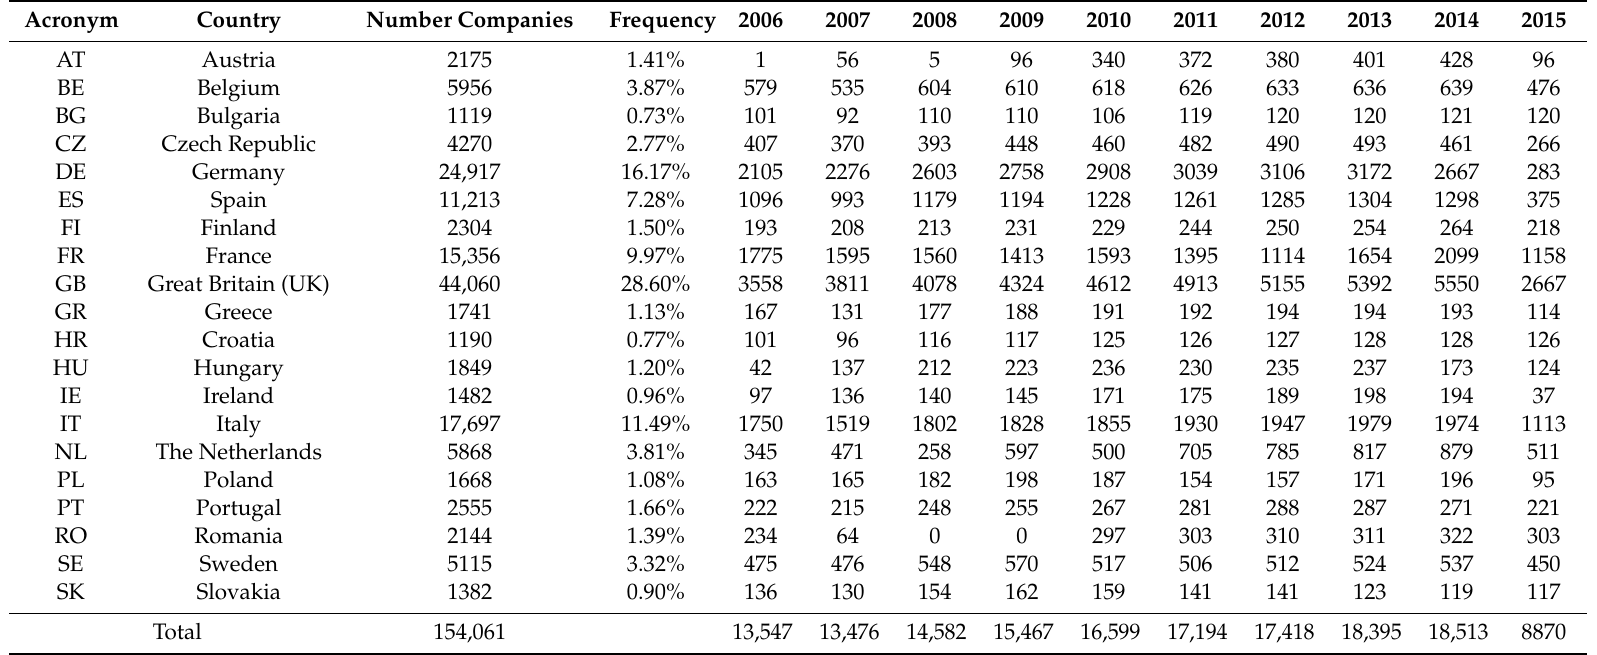
Table 1. Total number of companies within the sample by country and